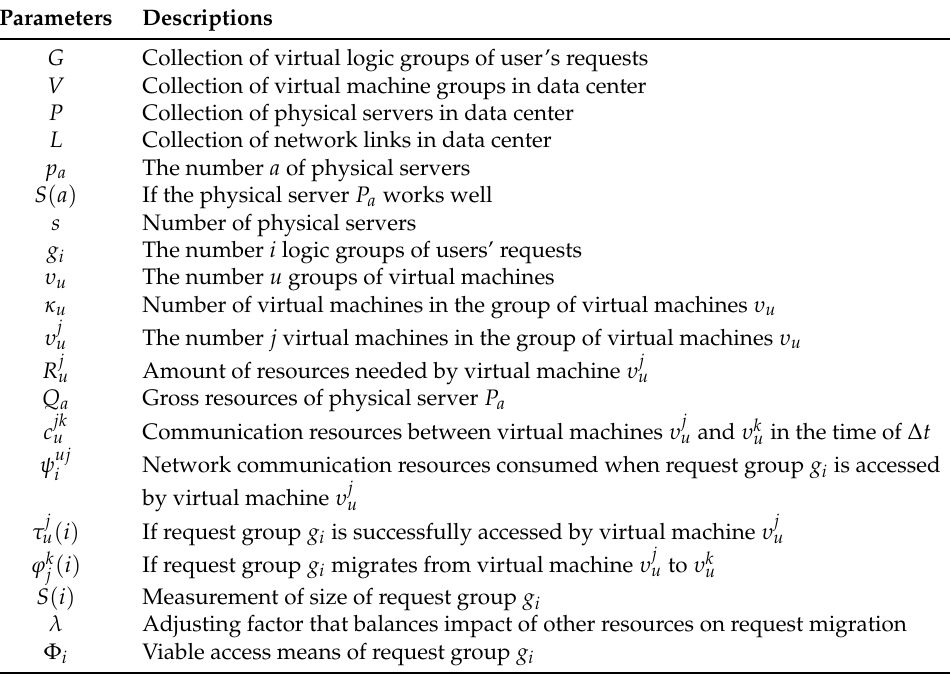
Table 1. Parameters of the DAPVDC